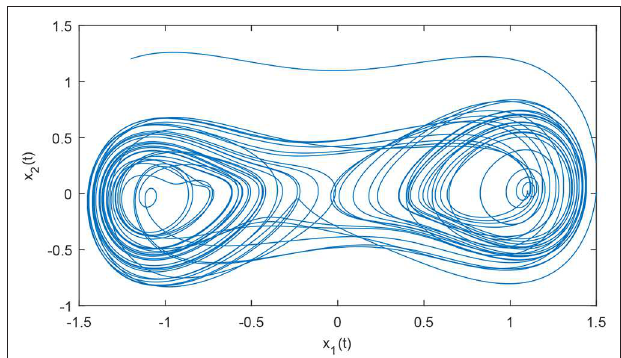
FIGURE 1 | Chaotic phenomenon of uncontrolled FODS